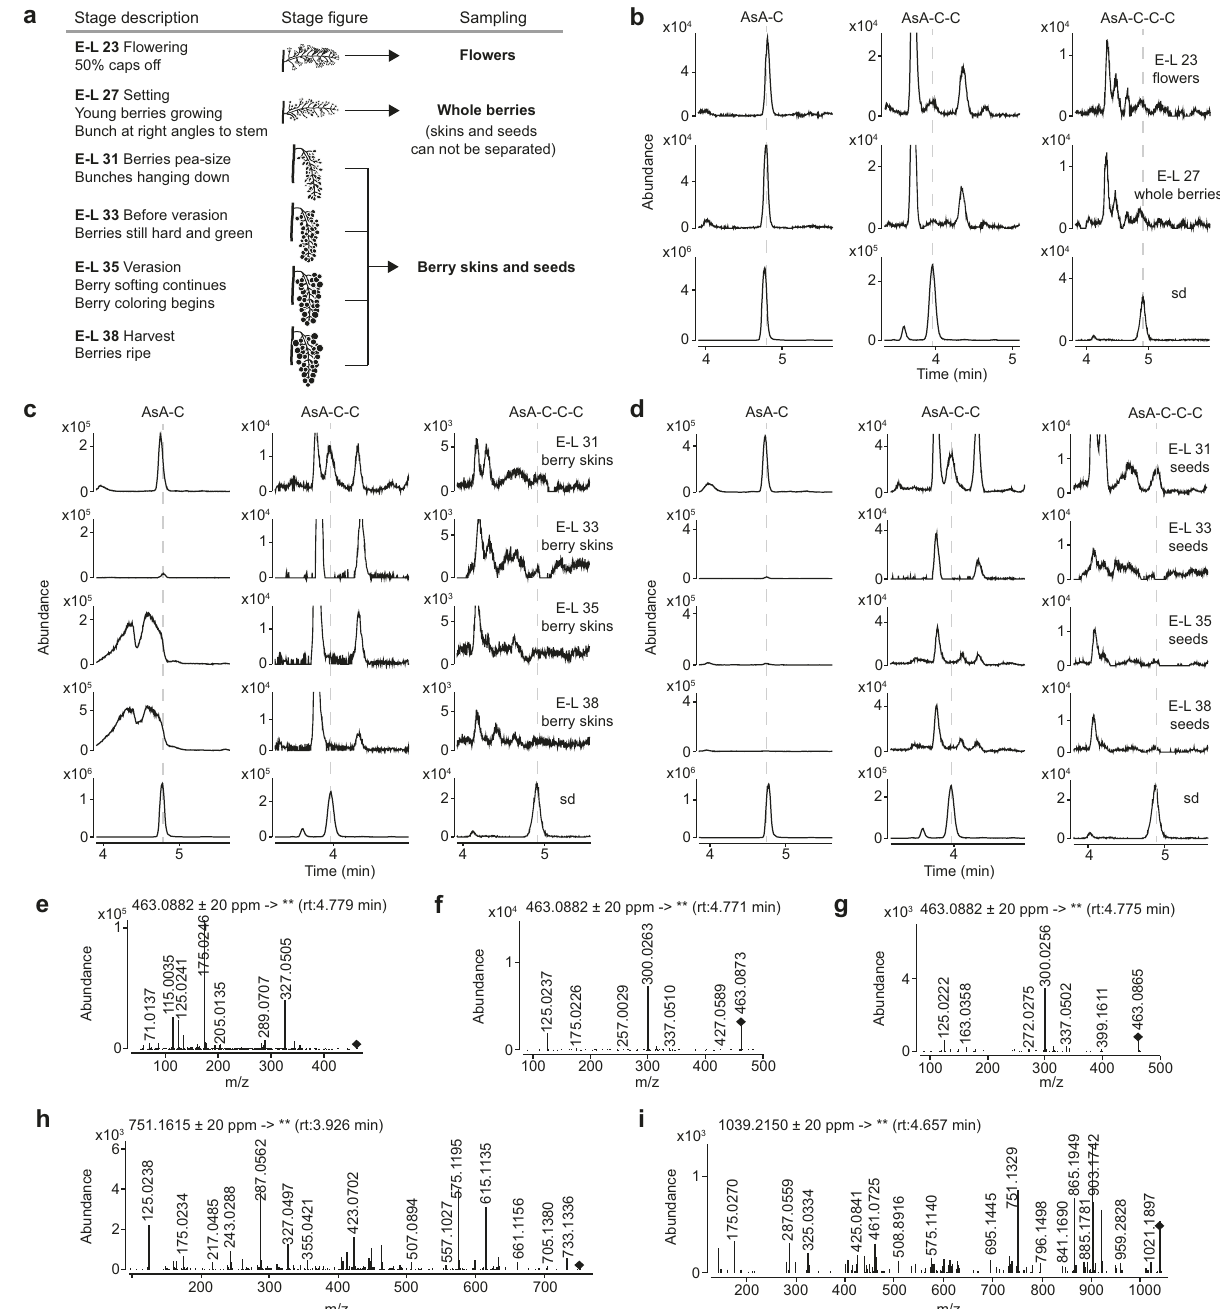
Fig. 7 AsA-[C] n exists in fl owers, berry skins, and seeds of grapevine at the stages of active PA biosynthesis. a Stages analyzed. b Targeted detection of AsA-C (EIC at m/z 463.0882± 20 ppm), AsA-C-C (EIC at m/z 751.1615 ± 20 ppm) and AsA-C-C-C (EIC at m/z 1039.2150 ± 20 ppm) in grape fl owers (E-L 23) and setting berries (E-L 27) using UHPLC-QToF. c Targeted detection of AsA-[C] n in grape berry skins at stages E-L 31, E-L 33, E-L 35, and E-L 38 using UHPLC-QToF. d Targeted detection of AsA-[C] n in grape seeds at stages E-L 31, E-L 33, E-L 35, and E-L 38 using UHPLC-QToF. Product ion pro fi les of the target compounds in grape berry skins at E-L 31 are shown in ( e ), ( h ) and ( I ) respectively. f , g The product ions of m/z 463.0882± 20 ppm in grape berry skins at E-L 35 and E-L 38 indicate that the humped peaks in ( c ) do not contain AsA-C. The product of the reaction of AsA + leucocyanidin (Leu) serves as the standard (sd). rt, retention